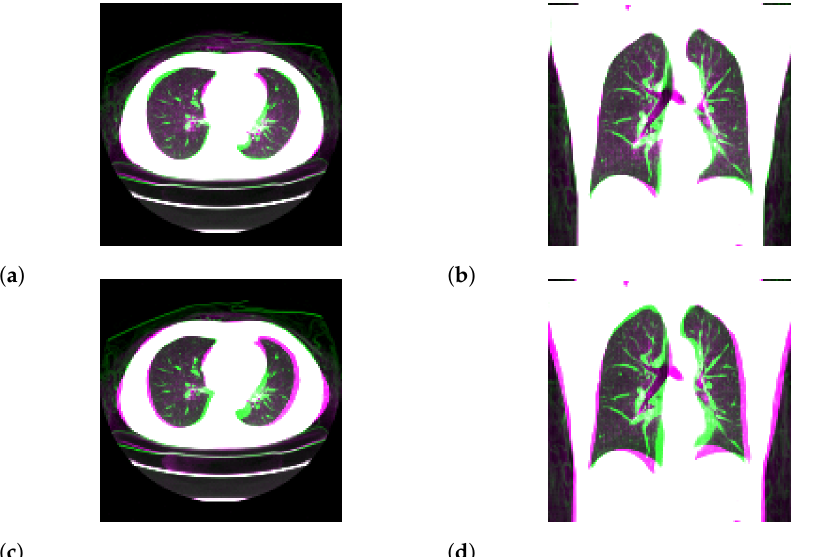
Figure 6. Superposition of the reconstructed 3D CT image (magenta) and the ground-truth image (green) in pulmonary window setting. ( a , b ) Partially enlarged axial and coronal views of Figure 5. ( c , d ) Partially enlarged axial and coronal views of Figure